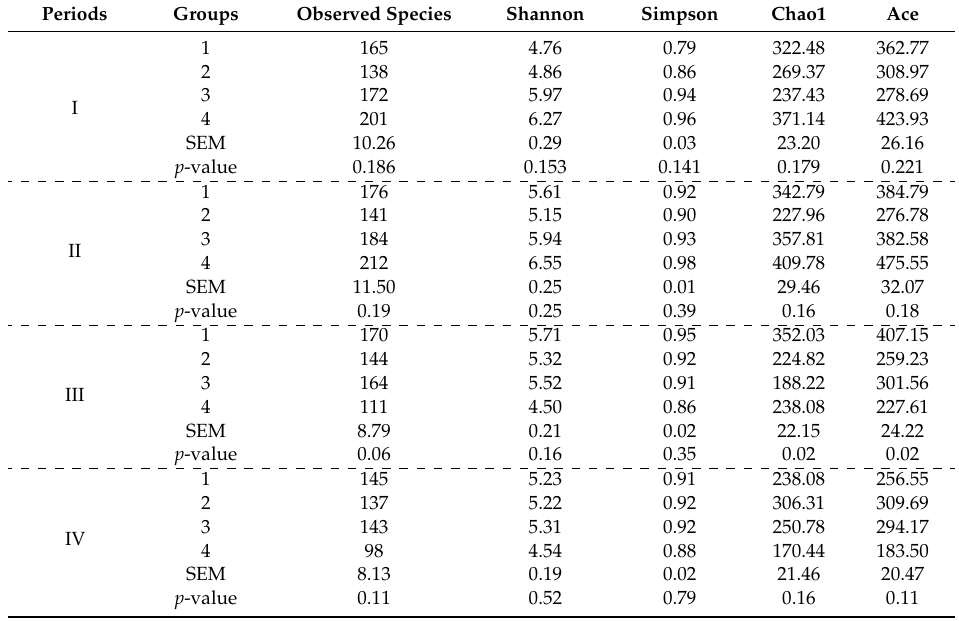
Table 2. Analysis of Alpha diversity at 0.03